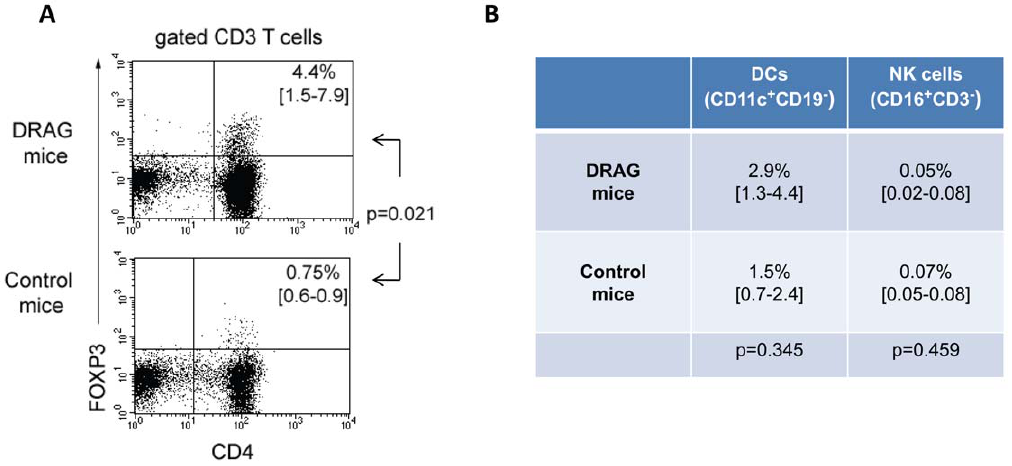
Figure 3. Expression of HLA-DR4 molecules in DRAG mice fosters development of Tregs but not of myeloid and natural killer cells. Panel A, frequency of CD4 + FOXP3 + Tregs among splenic T cells from DRAG (n=4) and control (n=2) mice that were examined at 6 months post- infusion of HSC (p=0.021). Panel B, frequency of dendritic cells (CD11c + CD19 2 ) and NK cells (CD16 + CD3 2 ) in spleens of DRAG (n=3) and control (n=2) mice at 6 months post-infusion of HSC. The cut-off for positive cells was 0.09% for DCs, and 0.01% for NK cells. P values were calculated using Independent Samples t-test.